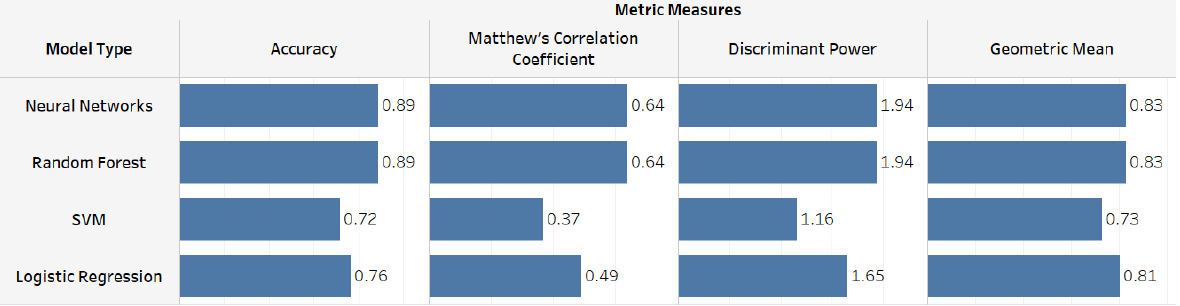
Table 2. A summary of the models’ performances on the testing data. It evaluates the applied model scores utilizing every group based on four performance metrics. The shaded columns highlight the comparison between all gait features models (Group 1) and GRF features (Group